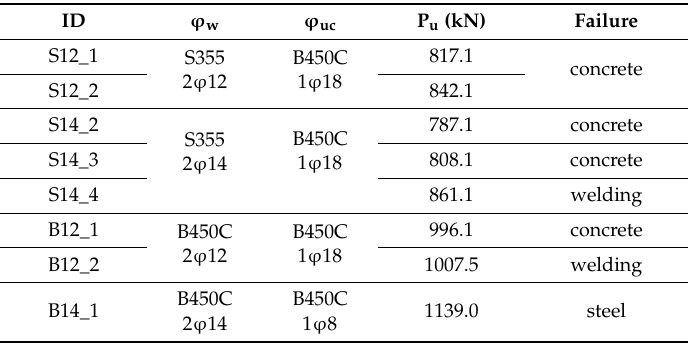
Table 2. Features of specimens tested by Aiello